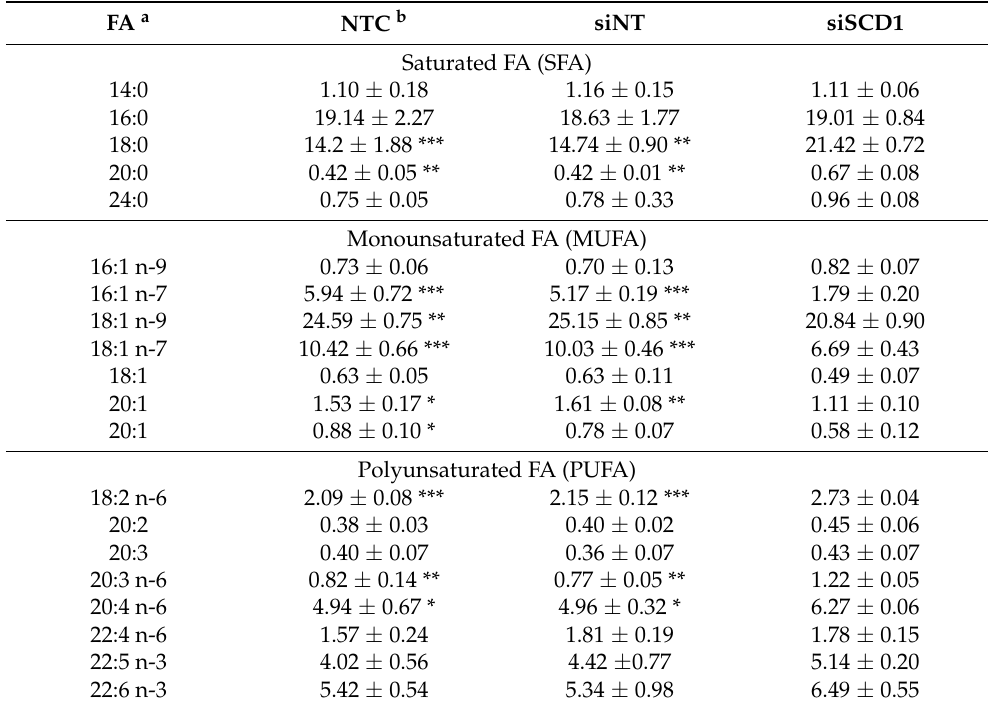
Table 1. Relative abundance (%) of fatty acids (FAs) in U87 cell lipids. Cells, grown in medium containing 2% FBS were transfected with siRNA against SCD1 (siSCD1) or a non-targeting siRNA sequence (siNT) complexed with Lipofectamine RNAiMAX. Sixty-eight hours after transfection, lipids were extracted and their FA composition determined by